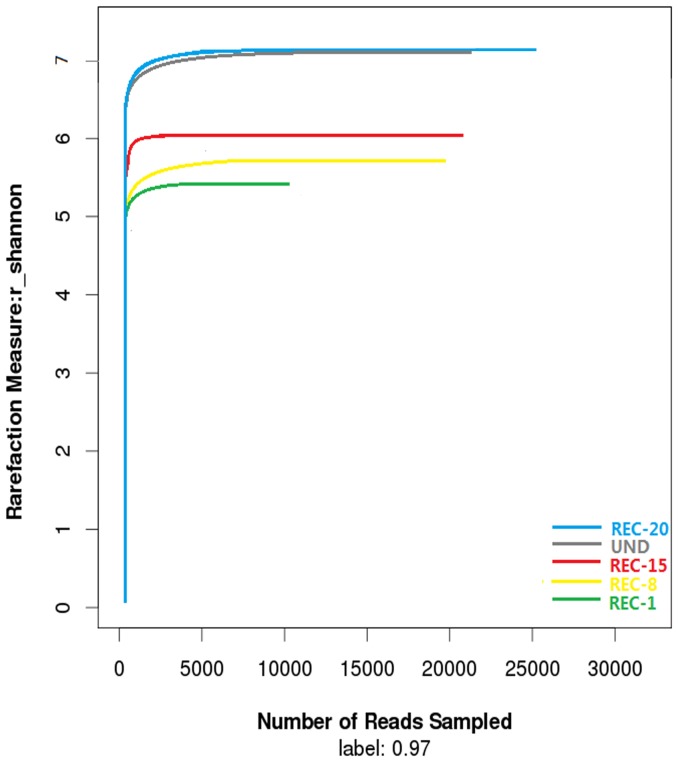
Shannon Wiener curves of samples.Shannon Wiener curves of OTUs clustered at 97% sequence identity across different samples from reclamation sites of different ages (REC) and the undisturbed reference (UND).